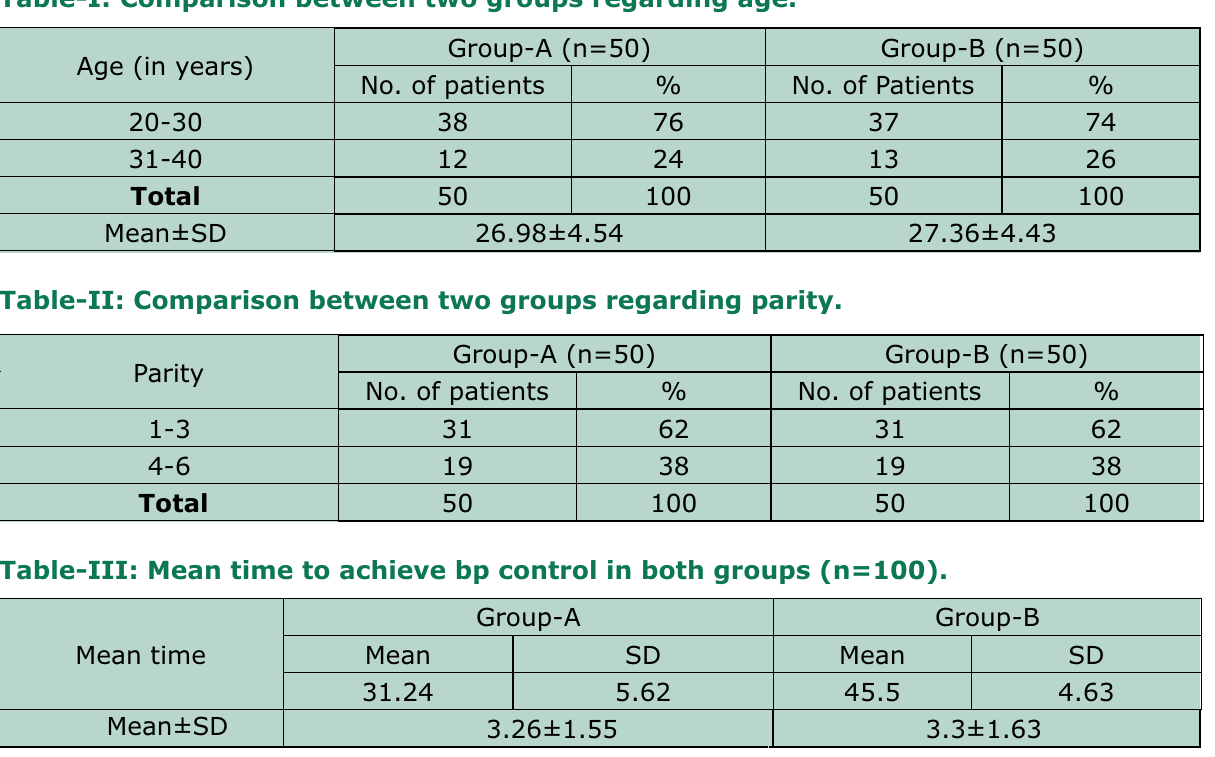
Table-I: Comparison between two groups regarding age.